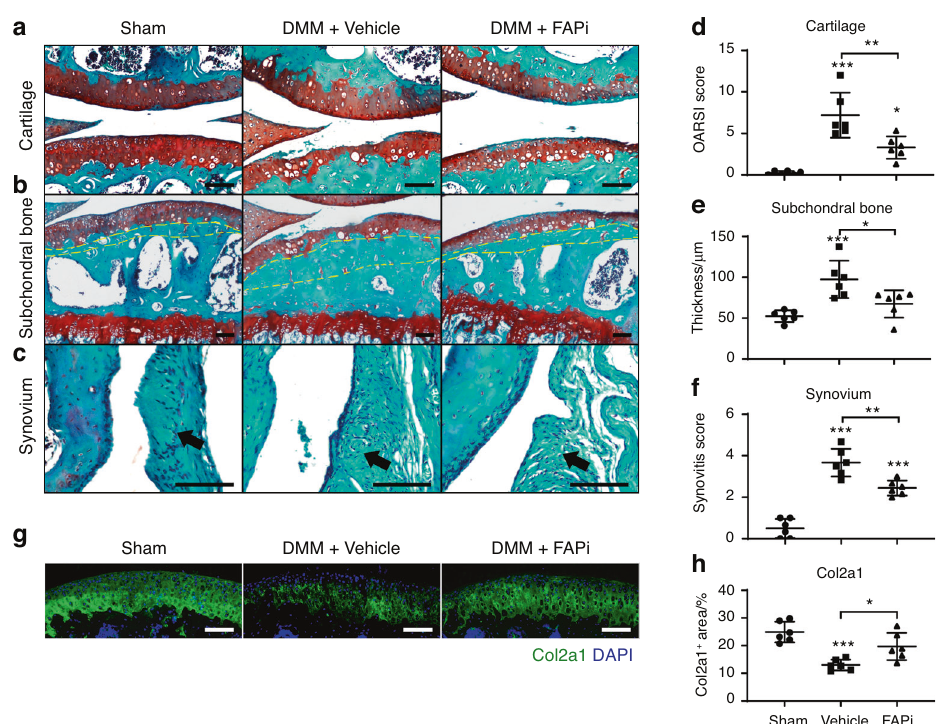
Fig. 3 Pharmacological inhibition of Fap ameliorates joint symptoms after the onset of OA. a – c Safranin O/Fast Green staining in wild-type mice treated with FAPi or vehicle after DMM surgery. Weekly intra-articular administration of FAPi (40 μ g·kg − 1 body weight) or vehicle (PBS) was performed 4 weeks after DMM surgery in 10-week-old mice and continued for 8 weeks before paraf fi n sectioning and safranin O/fast green staining of the knee joints. Representative cartilage erosion ( a , top: femur, bottom: tibia), subchondral bone thickening ( b ) and synovitis ( c ) images are shown ( n = 6 mice per group). Yellow dotted lines indicate the subchondral bone plate. Arrows indicate the synovium. Scale bars: 100 μ m. d – f Quanti fi cation of the OARSI score ( d ), subchondral bone thickness ( e ) and synovitis score ( f ). g , h Immunostaining of Col II in the knee joints ( g ) with quanti fi cation ( h ) ( n = 6 mice per group). DAPI staining indicates the nucleus. Scale bars: 100 μ m. The statistical signi fi cance was assessed using one-way ANOVAs with Tukey ’ s multiple comparison tests. Data are presented as the mean ± SD (* P < 0.05, ** P < 0.01, *** P <